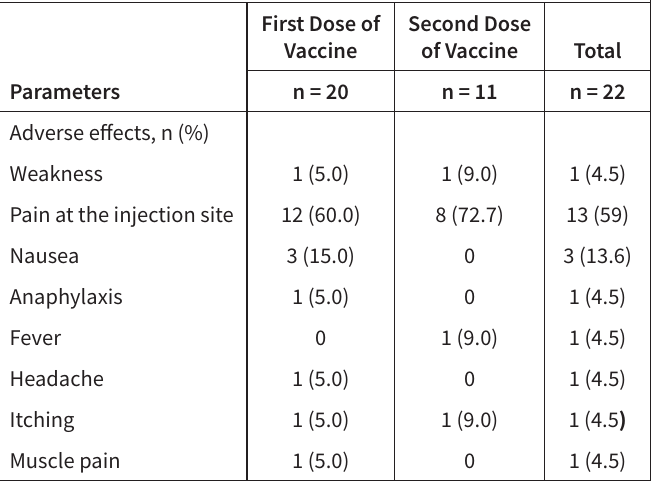
First Dose of Second Vaccine